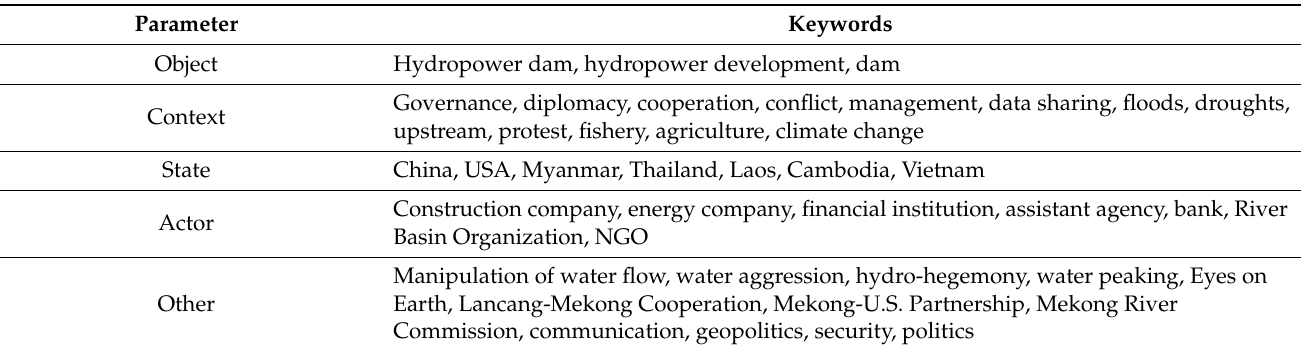
Table 1. List of searching parameters and keywords for retrieving data from the